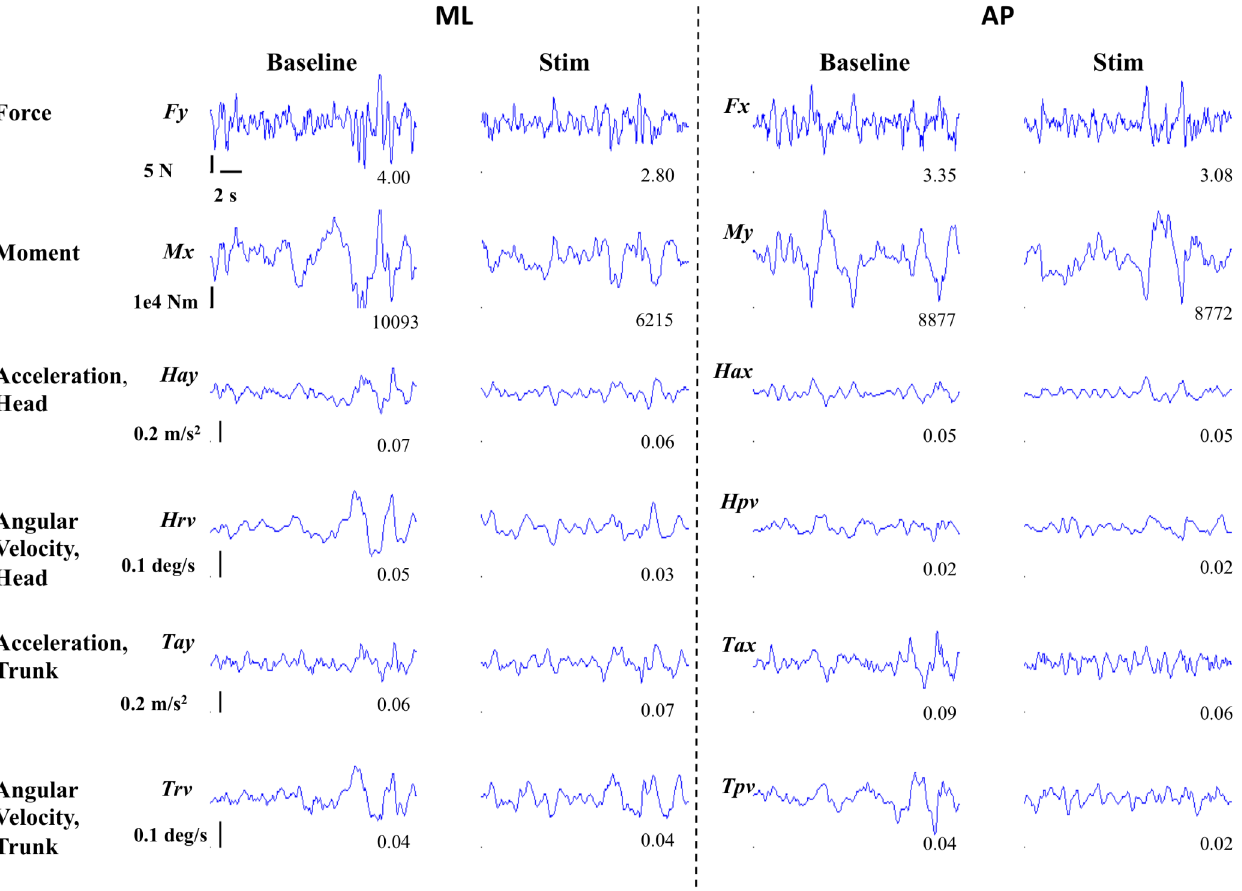
Fig 1. An exemplar plot of the 12 measures (ML direction: Fy, Mx, Hay, Hrv, Tay, Trv and AP direction: Fx, My, Hax, Hpv, Tax, Tpv) of interest for one subject during the balance task, for both baseline and stimulus periods for an optimal trial at the level of 350 μ A (= 40% of this subjects perceptual threshold). Numerals in the bottom right of each panel represent RMS